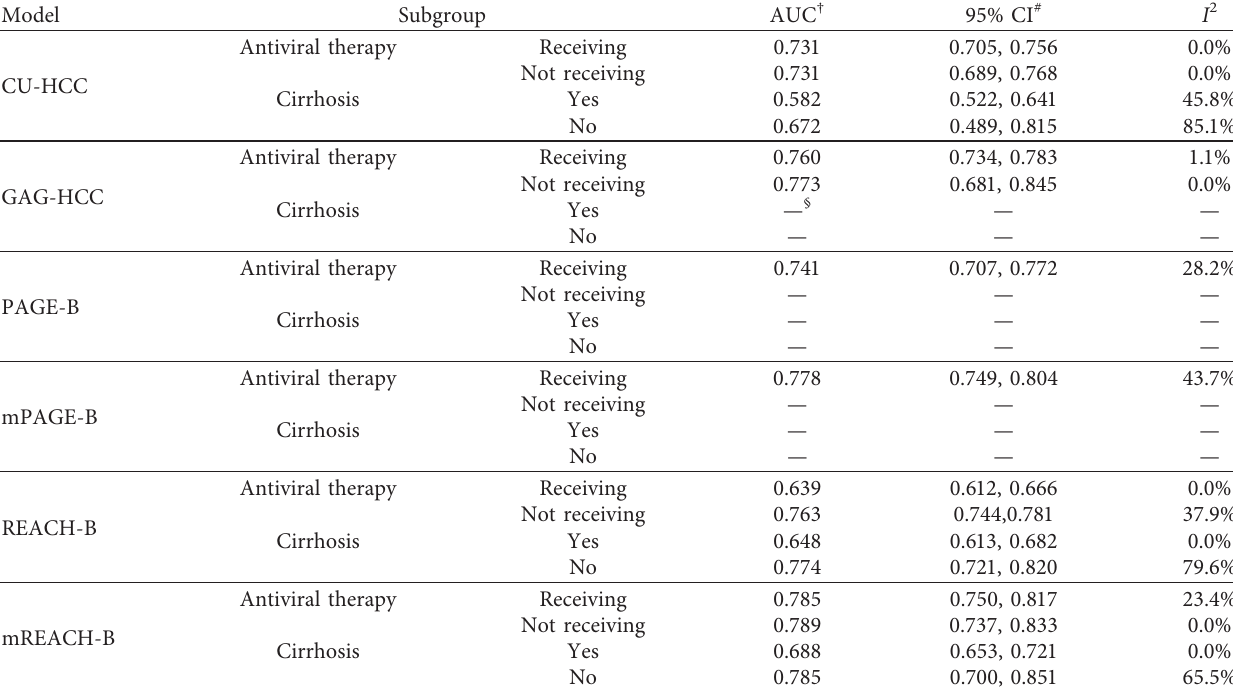
Table 3: Analysis of the predictive performance of each model in